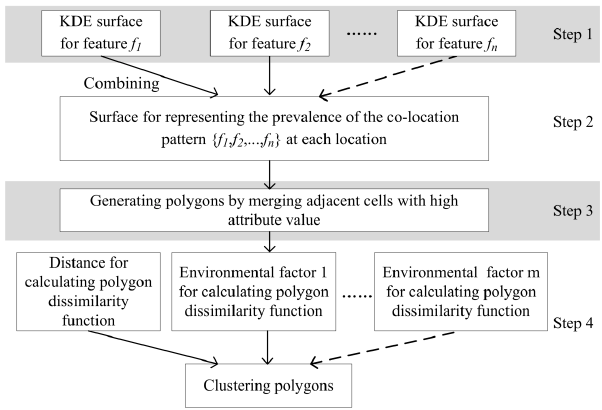
Figure 1. Framework for prevalent region analysis using kernel density estimation (KDE) and polygons clustering.